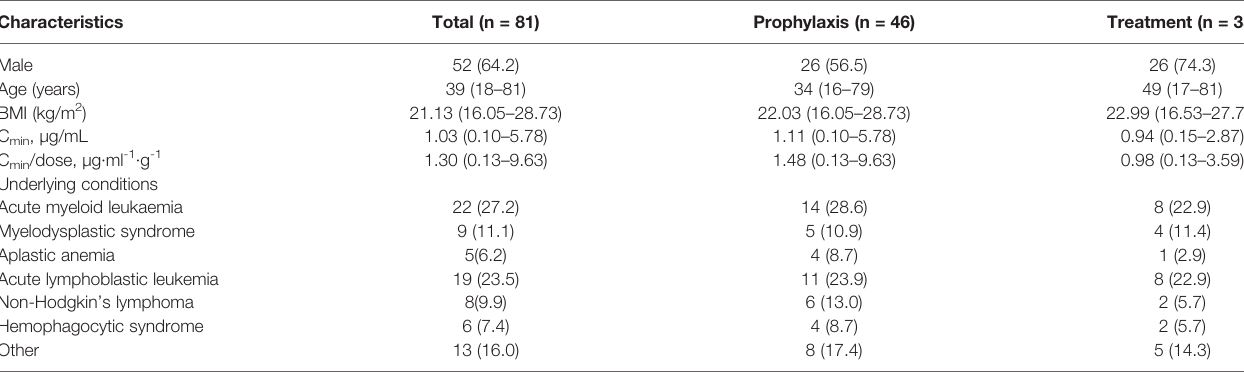
TABLE 1 | Patient characteristics (n = 81).